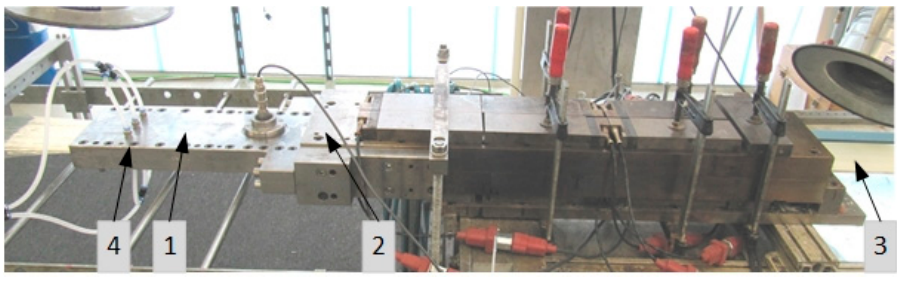
Figure 3. Pultrusion setup .